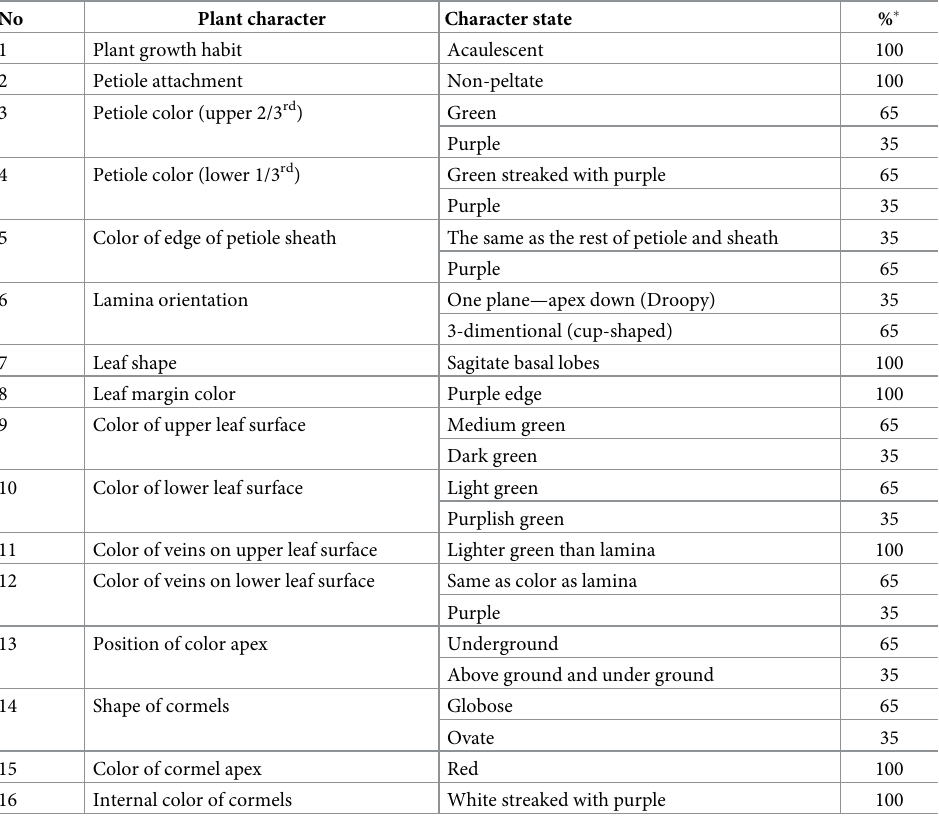
Table 1. Frequency distribution of 16 qualitative traits of cocoyam accessions. No Plant character Character state % � 1 Petiole attachment